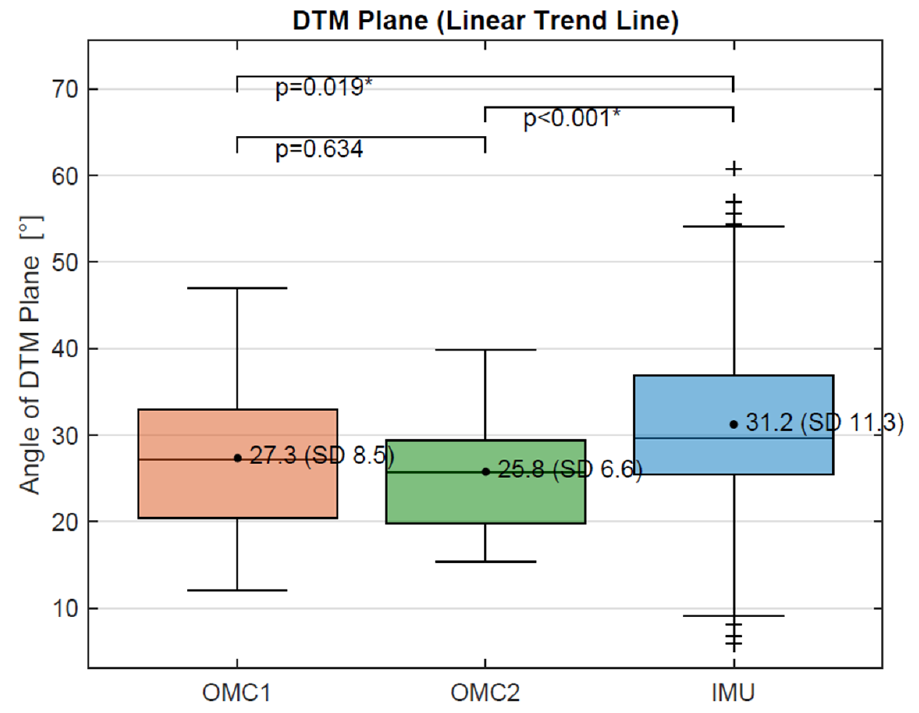
Figure A2. Angle of the calculated DTM plane by the three measurement methods OMC1, OMC2, and IMU. Statistically different values were found between IMU and OMC1 and between IMU and OMC2. For Values marked as *, the difference is statistically significant.